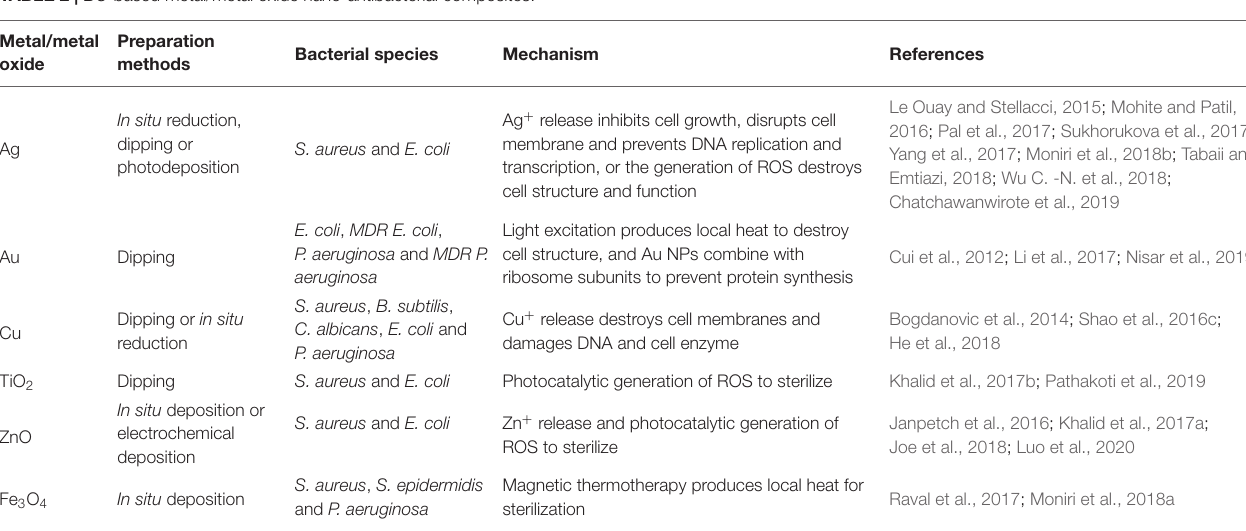
FIGURE 4 | (A) Structural formula of four common antibiotics. (B) Antibacterial properties of BC-TCH composite films with different TCH content (Shao et al., 2016a). TABLE 2 | BC-based metal/metal oxide nano-antibacterial